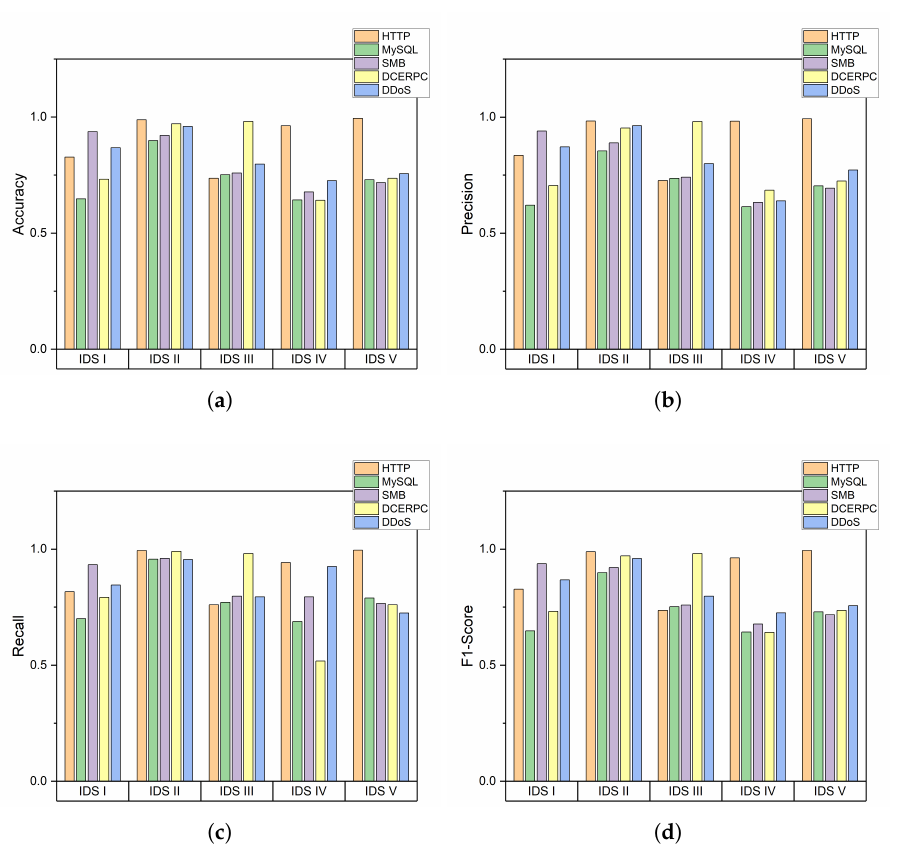
Figure 7. Performance of classification for each attack type: ( a ) Accuracy; ( b ) Precision; ( c ) Recall; and ( d )